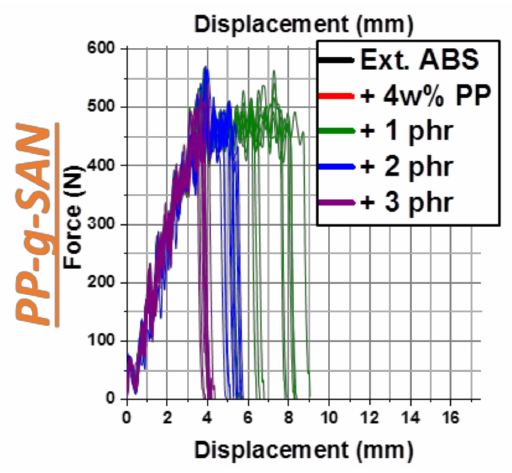
Figure 11. Force–displacement curves of unnotched Charpy impact of ABS—virgin and 4 wt% PP contaminated (1st line), added with 1, 2 and 3 phr of SEBS (2nd line) or PP-g-SAN (3rd line)—color associated with additive